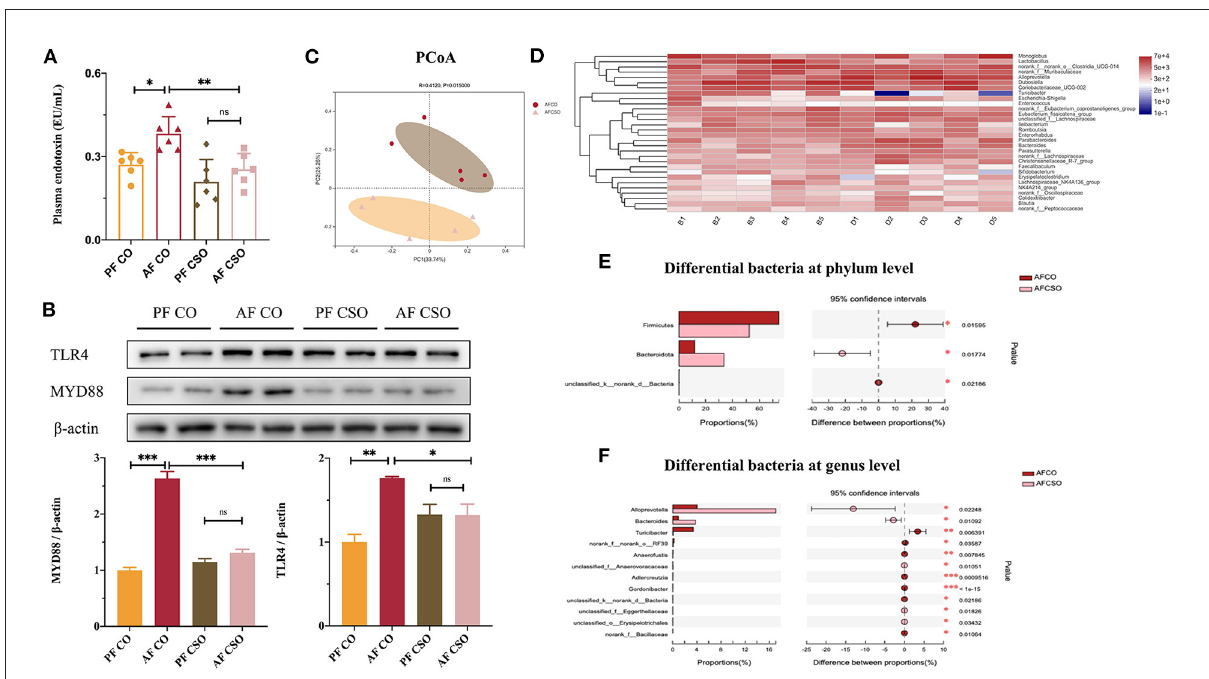
FIGURE5 Dietary CSO supplementation relieves alcohol-induced the imbalance of intestinal flora. (A) Plasma endotoxin level. (B) The expression of hepatic TLR4 and MYD88. (C) PCoA score plot. (D) Heatmap at genus level. (E,F) Kruskal–Wallis H -test bar plot on phylum level and genus level. * P < 0.05 and ** P < 0.01 indicate statistically significant.